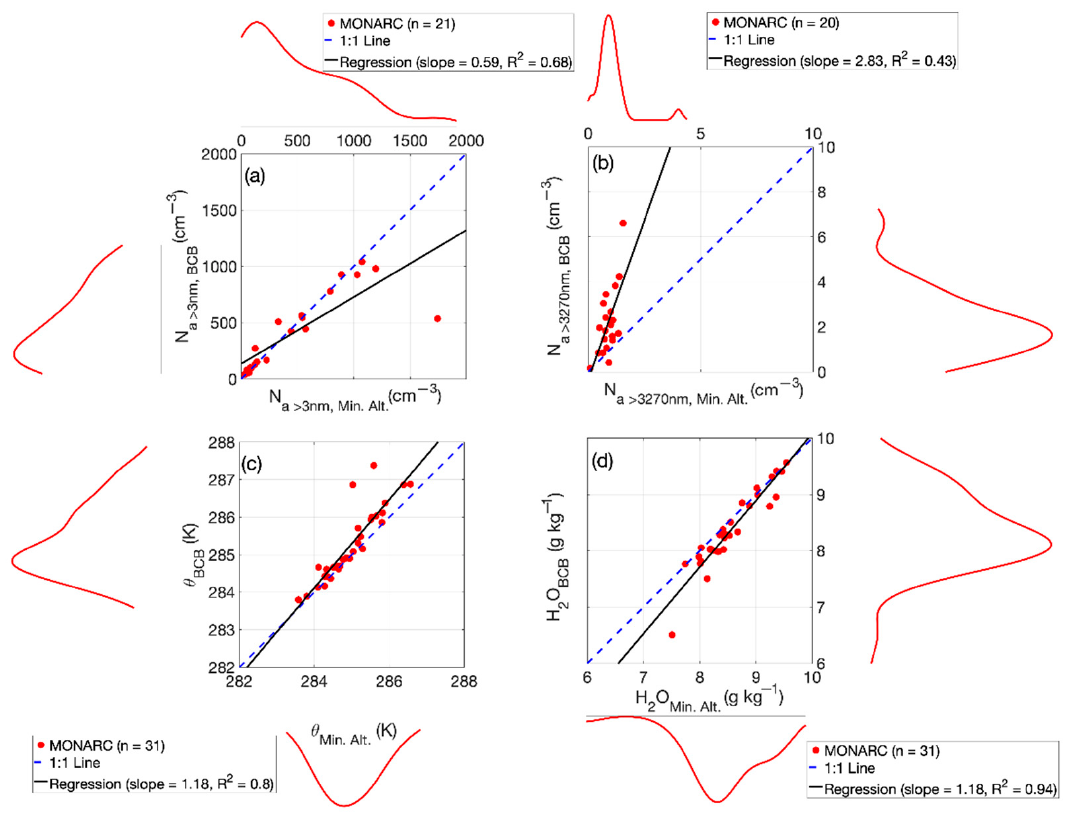
Figure 3. Scatterplots of leg-mean values for selected variables measured in BCB and Min. Alt. legs in cloud ensembles during 2019 MONARC flights. The plots on the sides are marginal distributions based on Kernel density estimation. An analogous figure for clear ensembles in MONARC can be found in Figure S1.